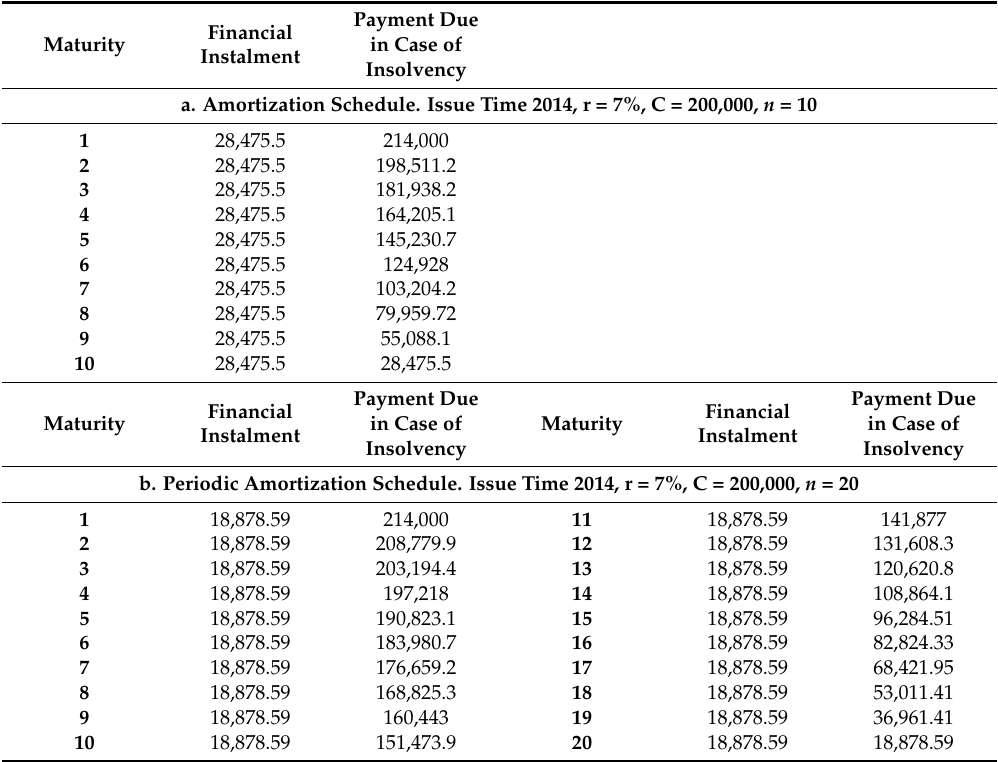
Table 7. Amortization